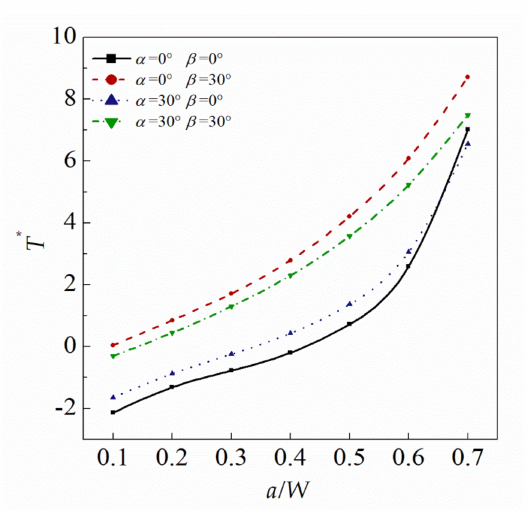
Figure 6. Variation of dimensionless T-stress T* under typical crack inclined angles for varying values of crack height ratio a/W .